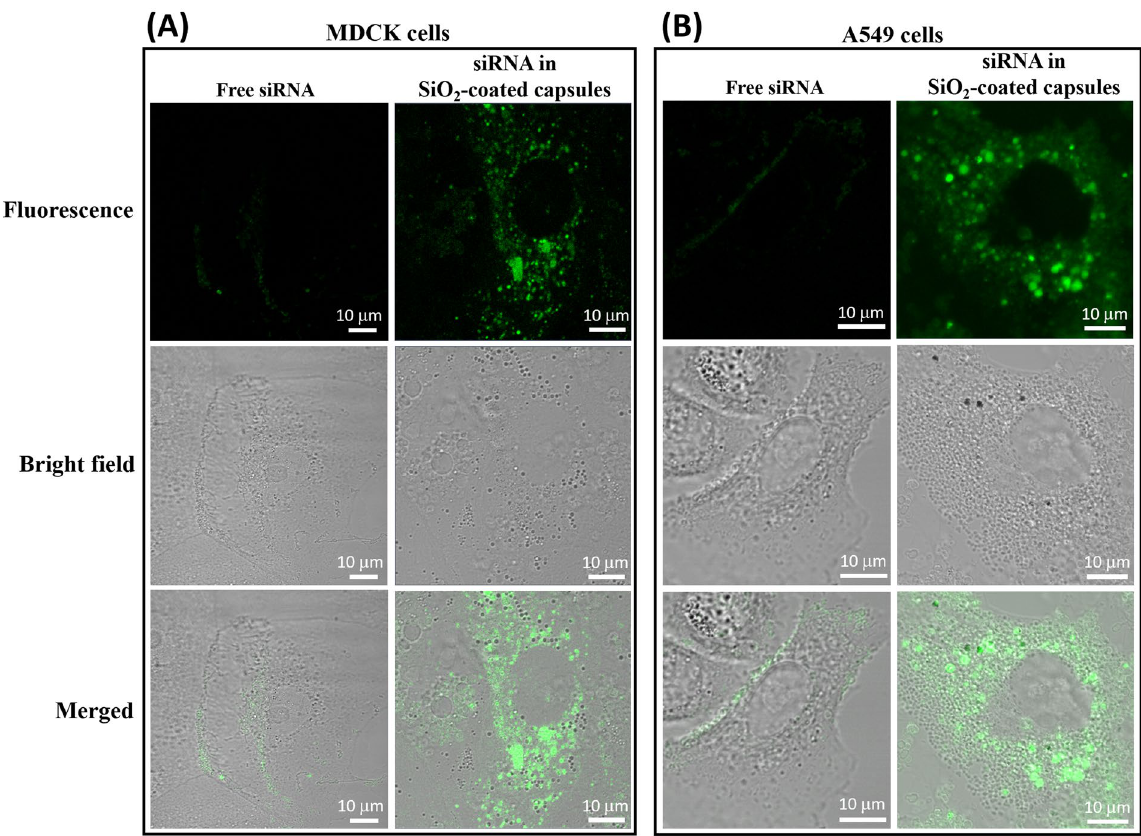
Figure 4. The uptake of fluorescently labeled siRNA (PA-1630-FAM) in MDCK ( A ) and A549 ( B ) cells in vitro . Confocal microscopy was used to compare the uptake and cellular localization of non-encapsulated and encapsulated siRNAs in SiO 2 -coated capsules after 8 h incubation with MDCK and A549